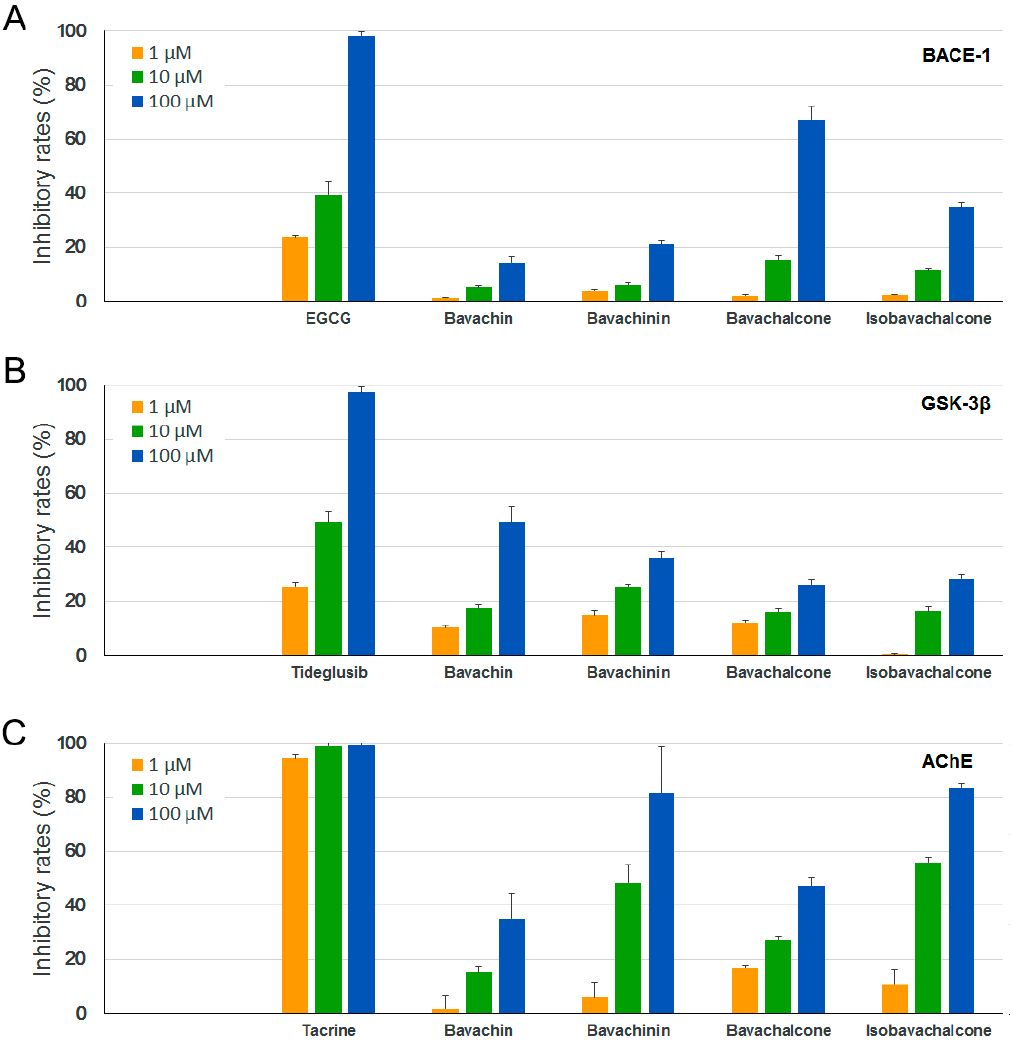
Figure 4. Inhibitory effects of PF compounds on ( A ) β -secretase (BACE-1), ( B ) glycogen synthase kinase 3 β (GSK-3 β ); and ( C ) acetylcholinesterase (AChE). Epigallocatechin gallate (EGCG), tideglusib, and tacrine were used as positive controls, respectively. Data are expressed as mean ± SEM.